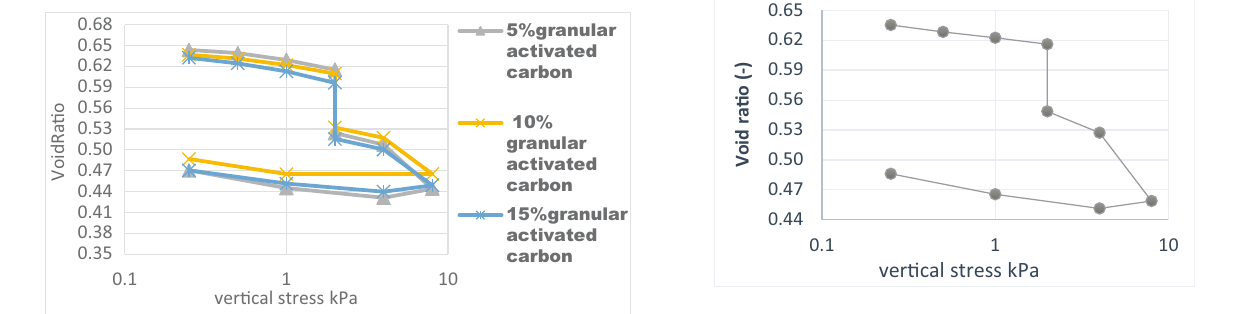
Figure 4: Collapse test results for soil treated with 10% powder activated